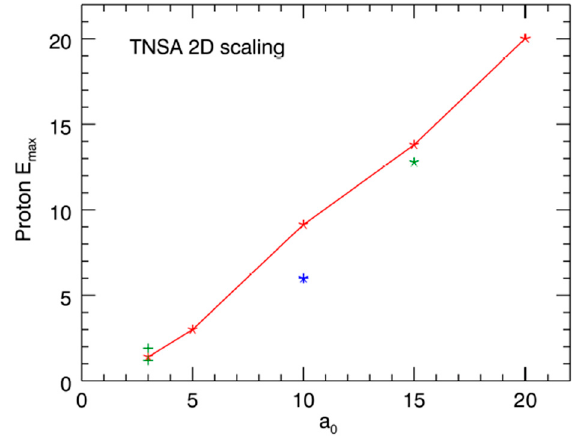
Figure 3. Calculated protons cut-off energy (MeV) at different laser intensities with strength parameter a 0 = 3–20. Data on the red line all refer to laser pulse duration τ = 30 fs, incidence angle θ = 10 ° , and target thickness l th = 2 μ m. Different data at a 0 = 3, Emax = [1 . 2, 1 . 4, 1 . 82] MeV refer to different incidence angles ( θ = 0–30 ° ). The lower value at a 0 = 10 refers to a larger l th = 2 . 5 target thickness, whereas the lower value at a 0 = 15 refers to a lower τ = 25 fs pulse duration. TNSA: Target Normal Sheath Acceleration.